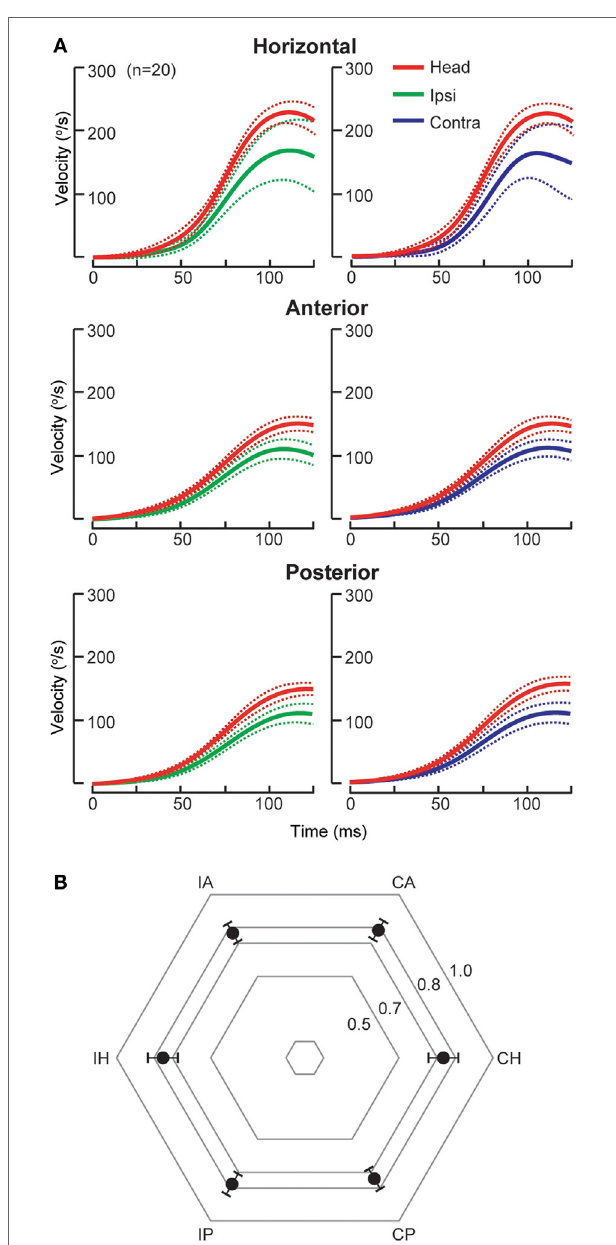
FiGURe 1 | Individual semicircular canal (SCC) function in posterior inferior cerebellar artery ( n = 17) and superior cerebellar artery stroke (SCA, n = 3). (A) Group data (mean, solid lines; 95% confidence interval, dashed lines) displayed as time series of inverted eye and head velocities during the first 125 ms of head impulses, recorded using search coil HIT (scHIT). SCC function is indicated by the gain, the ratio of eye to head velocity. There is mild bilateral HC impairment (gain: ipsilateral 0.75 ± 0.09, contralateral 0.74 ± 0.08), while both AC (gain: ipsilateral 0.76 ± 0.06, contralateral 0.78 ± 0.06) and PC function (gain: 0.77 ± 0.06, contralateral, 0.74 ± 0.06) is intact. Note for SCC function evoked by scHIT, the lower limit normal for gain is ~0.8 for HC and ~0.7 for vertical SCC. (B) Radar plot depicting group data (mean, solid circles; 95% confidence interval, bars) displayed as gain for each SCC. IH, ipsilesional horizontal canal; IA, ipsilesional anterior canal; CA, contralesional anterior canal; CH, contralesional horizontal canal; CP, contralesional posterior canal; IP, ipsilesional posterior